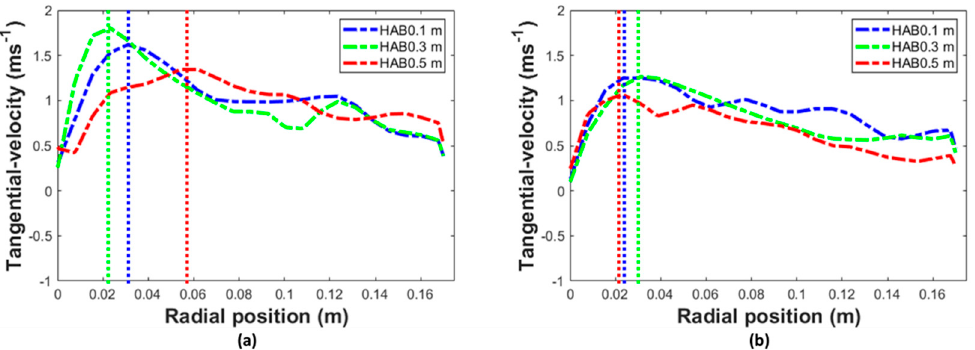
Figure 16. Plot of tangential velocity along with the radial direction at three monitoring HABs: 01 slit case ( a ), and 02 slit case ( b ).